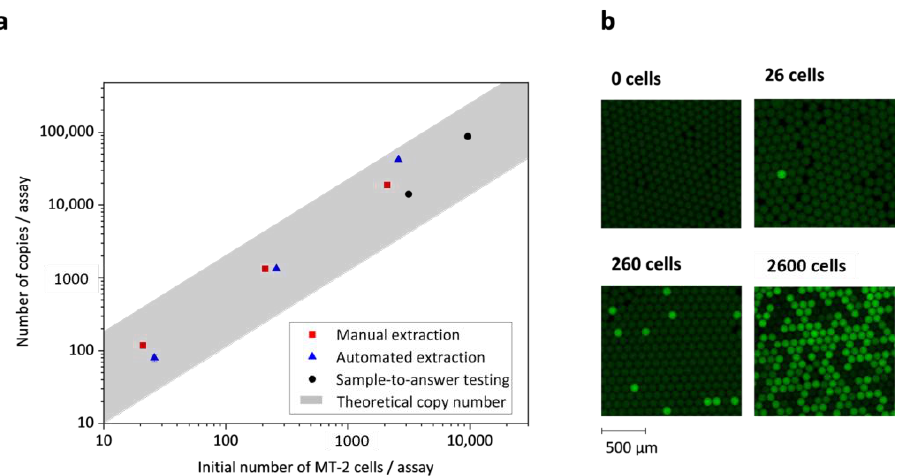
Figure 3. ( a ) The number of copies per assay determined (1) by digital loop-mediated isothermal amplification (dLAMP) of human T-cell lymphotropic virus type 1 (HTLV-1) with fresh reagents and manually extracted nucleic acids (red squares), (2) by dLAMP of HTLV-1 with fresh reagents and automated extraction of nucleic acids (blue triangles), and (3) by fully automated sample-to-answer testing (black circles). The calculated number of copies per assay is plotted against the theoretical CD4+ T-lymphocytes (MT-2) cell number per assay. The grey area illustrates the interval of nucleic acid copies per MT-2 cell given in the literature and ranges from 1 to 16 copies per MT-2 cell. ( b ) Crops of fluorescence images from the dLAMP of HTLV-1 for different MT-2 cell numbers per assay.